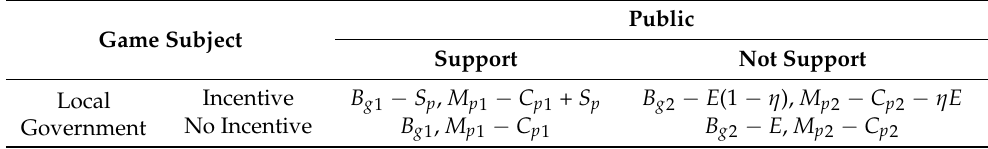
Table 8. The payoff matrix for local government and the